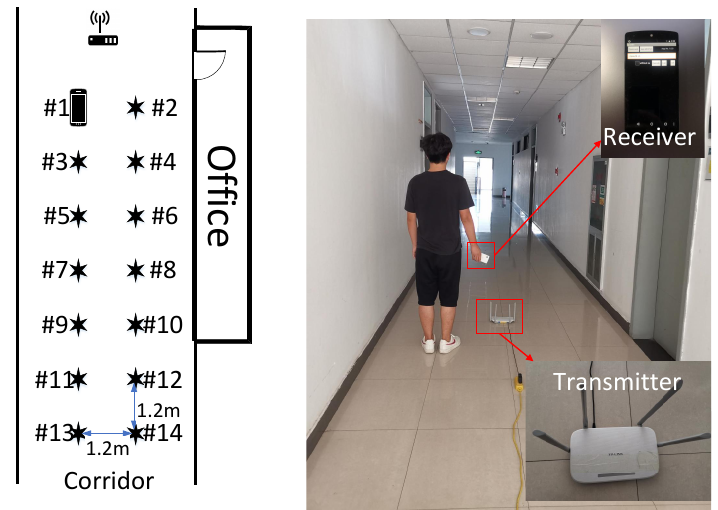
Figure 18. Experiment scene and planar graph of the corridor.